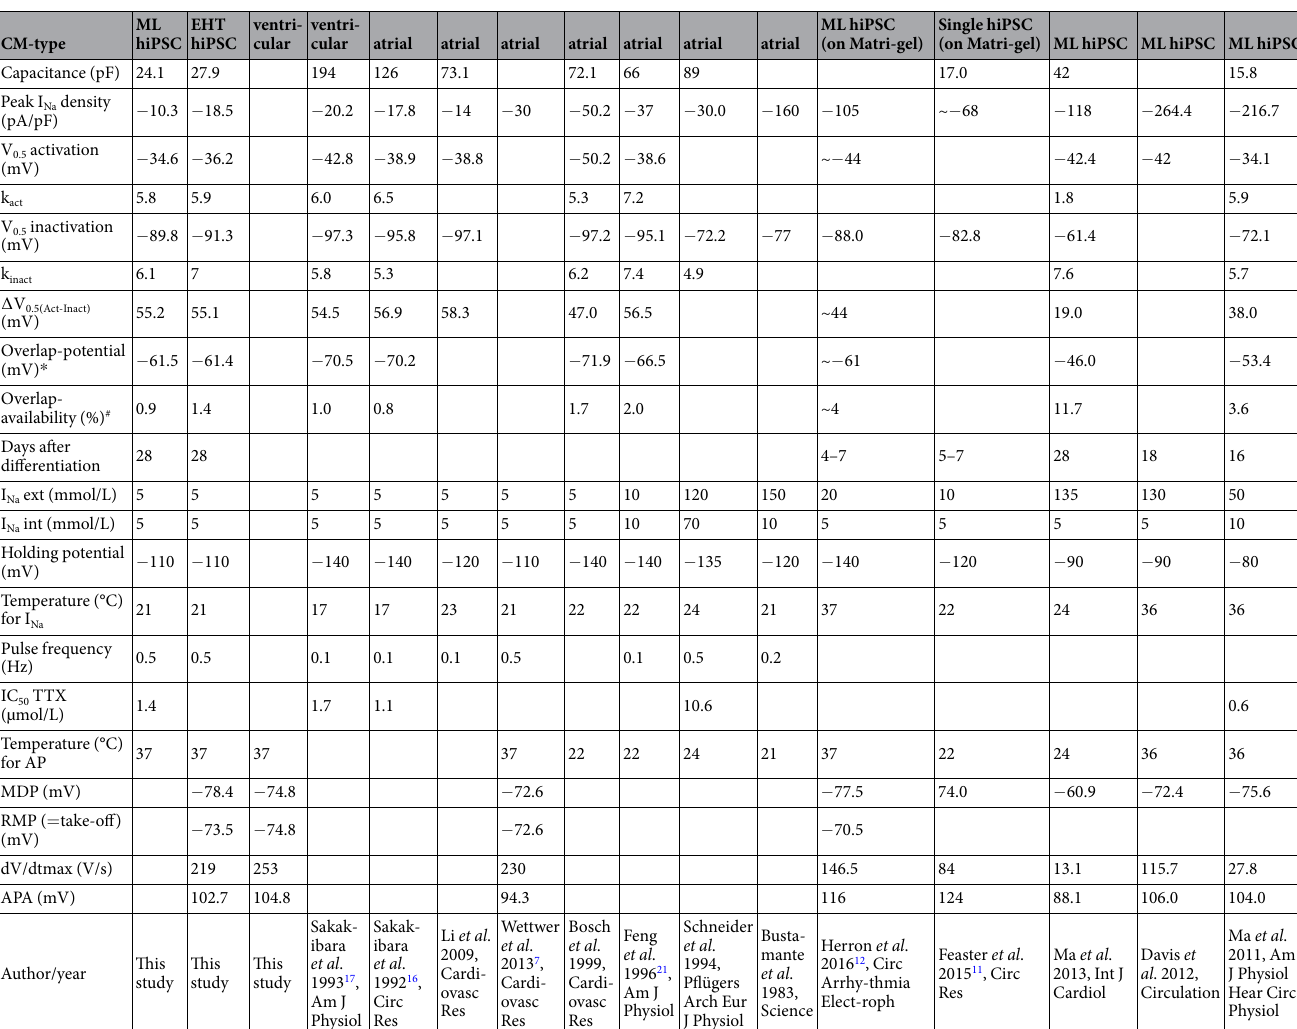
Table 2. Comparison of I Na properties in isolated human induced pluripotent stem cell-derived and adult cardiomyocytes. HiPSC-CM: human induced pluripotent stem cell-derived cardiomyocyte; ML: monolayer; EHT: engineered heart tissue; V 0.5 : voltage of half-maximal (in)activation; k: slope factor of voltage-dependence of (in)activation; * overlap-potential (V m ) was calculated: ((k act * V 0.5Inact ) − ( − k Inact * V 0.5act ))/(k Inact + k act ) (details in supplementary data); # availability at overlap (%) was calculated = 1/(1 + EXP (( − V0.5Inact + overlap-potential)/ k Inact)) * 100; I Na ext: sodium concentration of the extracellular (bath) solution, I Na int: sodium concentration of the intracellular (pipette) solution; MDP: maximum diastolic potential; RMP: resting membrane potential ( = take- off potential); dV/dtmax: maximum upstroke velocity; APA: action potential